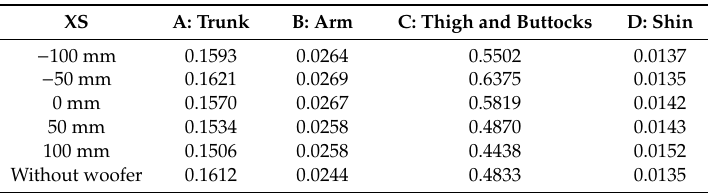
Table 5. Maximum electric field strength (V / m) variation in di ff erent measurement positions with the x -direction-adjusted woofer in the CFRP vehicle (YS = 0).